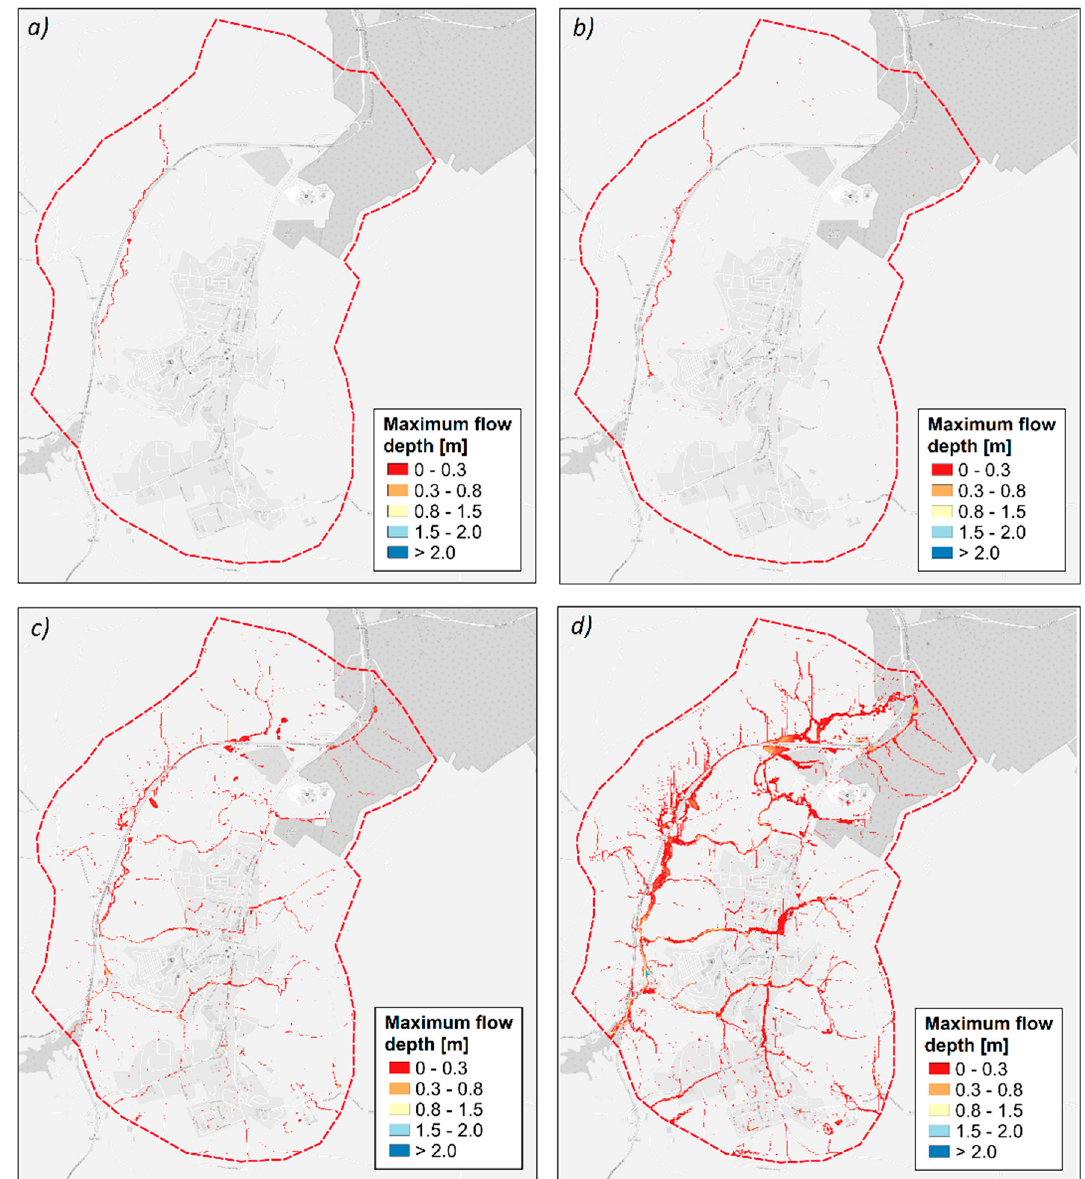
Figure 5. Maximum flow depth for the 2025 scenario: ( a ) T = 2 years; ( b ) T = 5 years; ( c ) T = 10 years; and ( d ) T = 20 years.